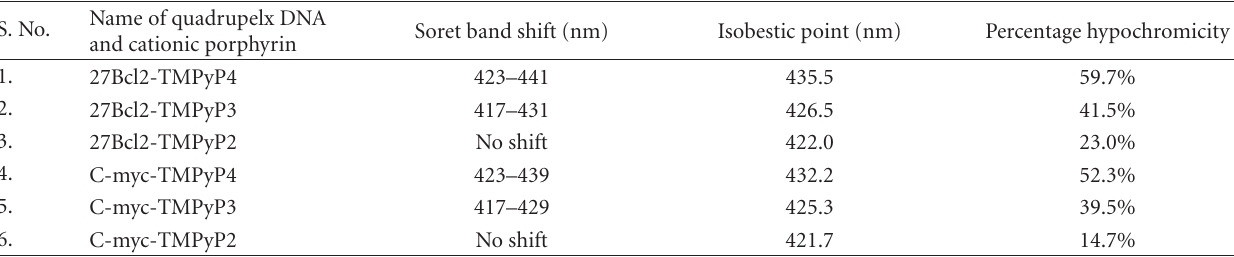
Table 1: UV-Vis absorption titration parameters for TMPyP4, TMPyP3, and TMPyP2 with four di ff erent Bcl2 and C-myc G-quadruplex DNA. Soret band hypochromicity is calculated using the formula: % Hypochromicity = [(C free − C bound ) / C free ] × 100. C free and C bound are the extinction coe ffi cient of free and bound porphyrin,